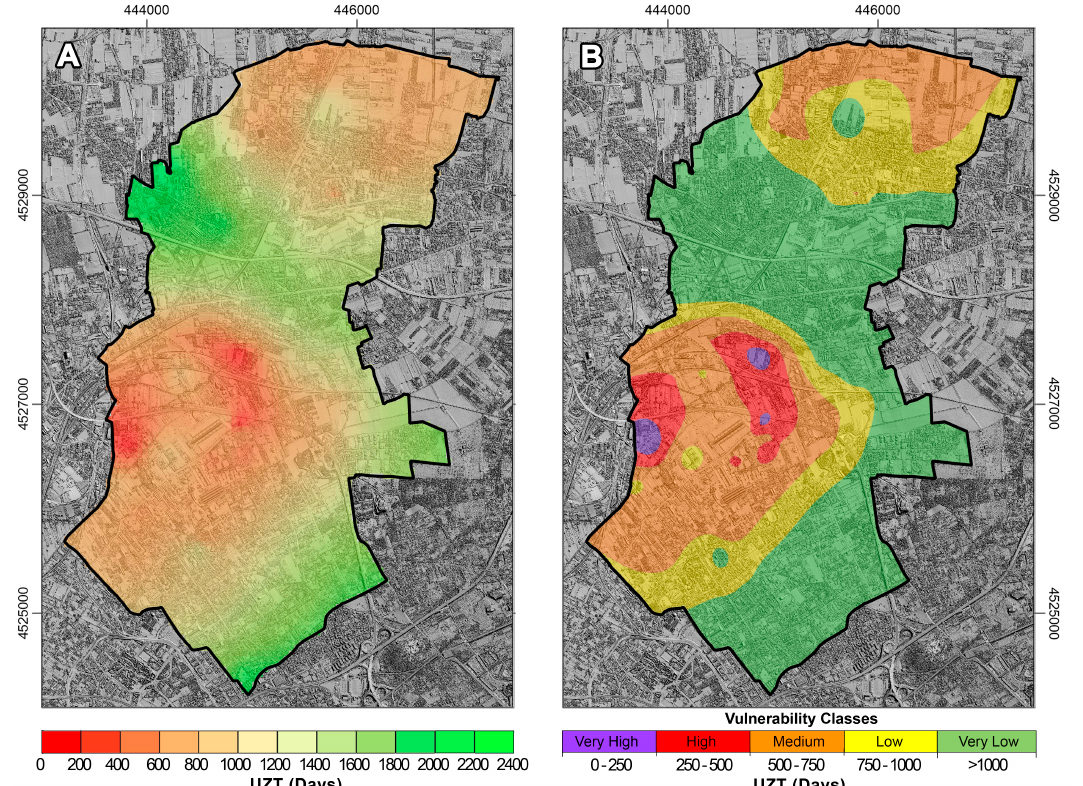
Figure 10. ( A ) UZT map of nitrate fertilizer pollutant through the unsaturated zone of the Casalnuovo-Volla alluvial aquifer; ( B ) groundwater vulnerability map.